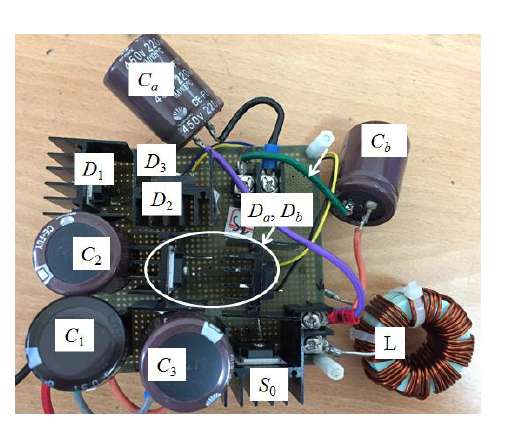
Figure 10. Prototype of the converter.